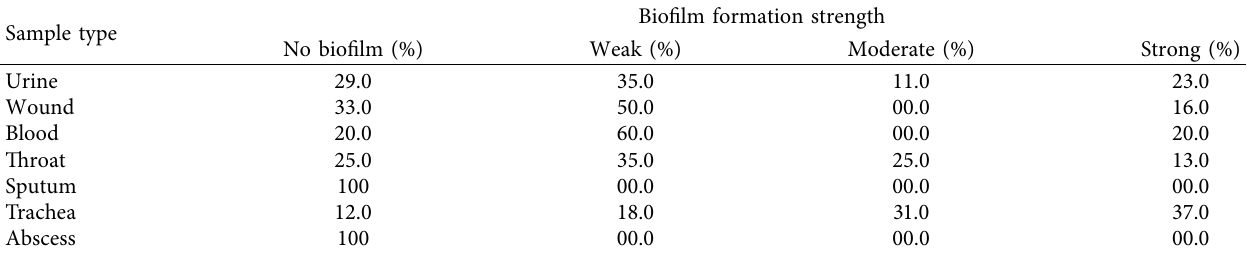
Table 2: Biofilm formation in K. pneumoniae isolated from different clinical